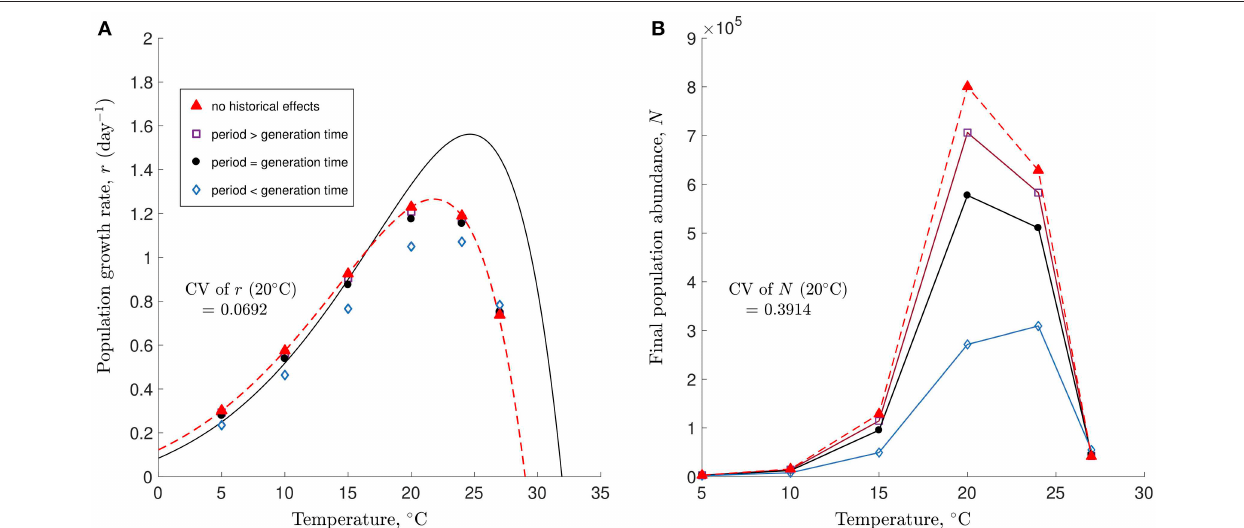
FIGURE 1 | Simulation of a stage-structured version of the continuous-time model presented in Kremer et al. (2018) with an initial density of 500 individuals and an experiment duration of 6 days. (A) Thermal Performance Curves based on population growth rate r are shown for constant temperatures (solid line) and fluctuating temperatures based on non-linear averaging (dashed red line). Simulations were run for temperature fluctuations whose period was greater than (open squares), equal to (filled circles), or smaller than (open diamonds) the generation time of the organism. Filled triangles falling on the dashed line (non-linear averaging curve) are for simulations with no historical effects. The acclimatization rate was set to σ = 10 (simulations with a slower acclimatization rate of σ = 0.8 were qualitatively identical, with the points being slightly more spread-out vertically). (B) Final abundances from the same simulations show the extreme variation in N (orders of magnitude). Coefficients of variation (CV) for r and N across all temperature fluctuation periods at 20 ◦ C shown in (A,B)